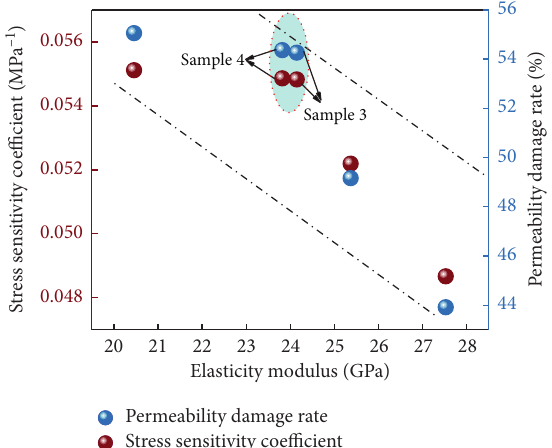
Figure 9: Relationship between modulus of elasticity and stress sensitivity coefficient and permeability damage rate of